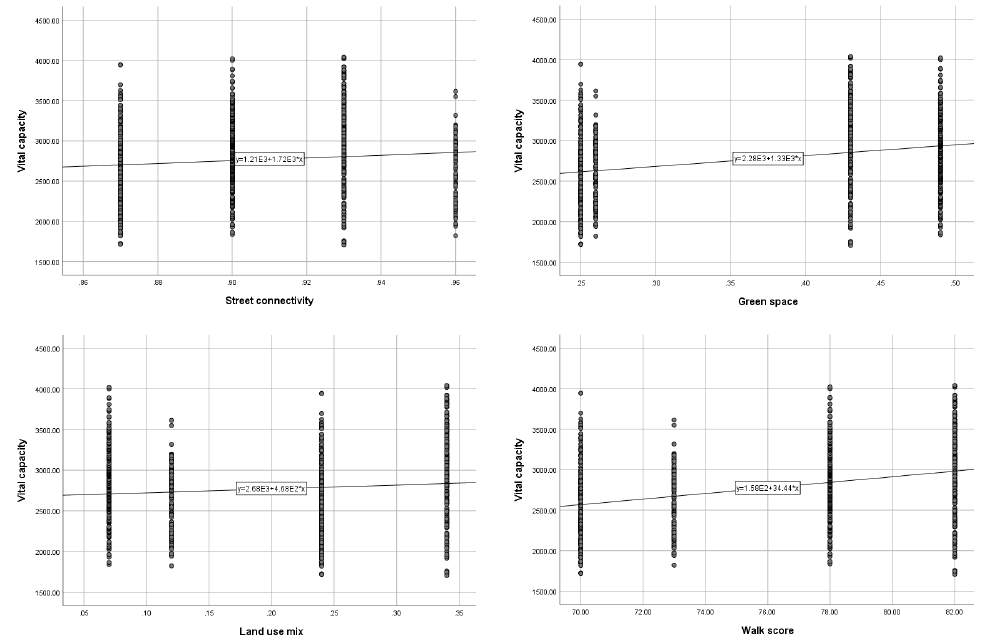
Figure A3. The specimen scatterplots for correlation between vital capacity and built environment in female students.